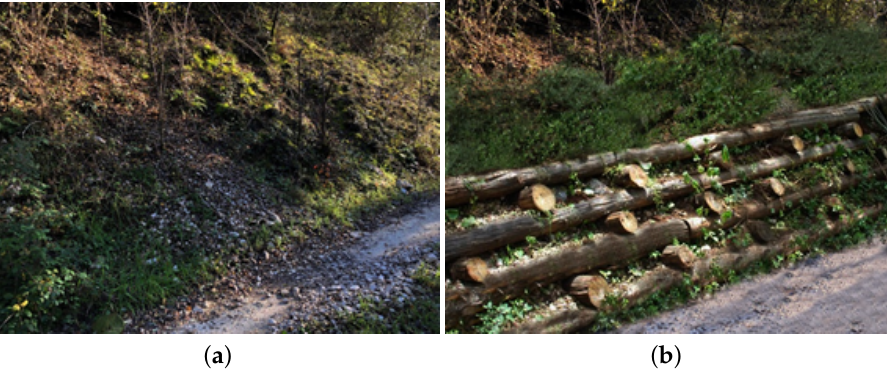
Figure 8. Simulated naturalistic work for S1 through photographic rendering: ( a ) initial condition of slope and ( b ) condition after naturalistic work